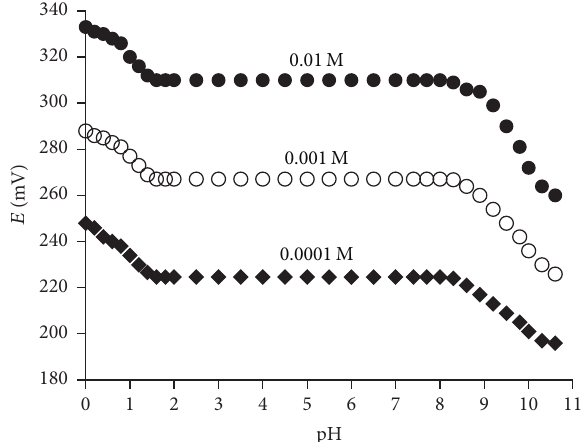
Figure 3: Effect of pH on potential response of CPE8.